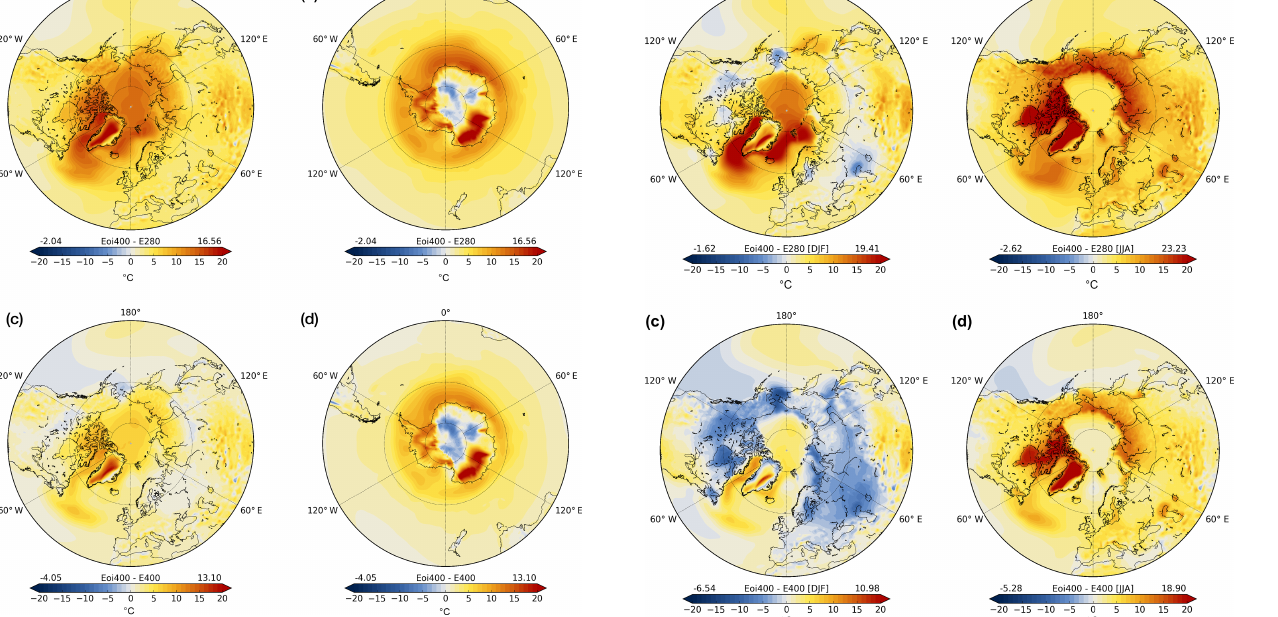
Figure 7. Similar to Fig. 6 but showing the mean seasonal surface air temperature anomalies: (a) and (c) are for DJF, (b) and (d) are for JJA.